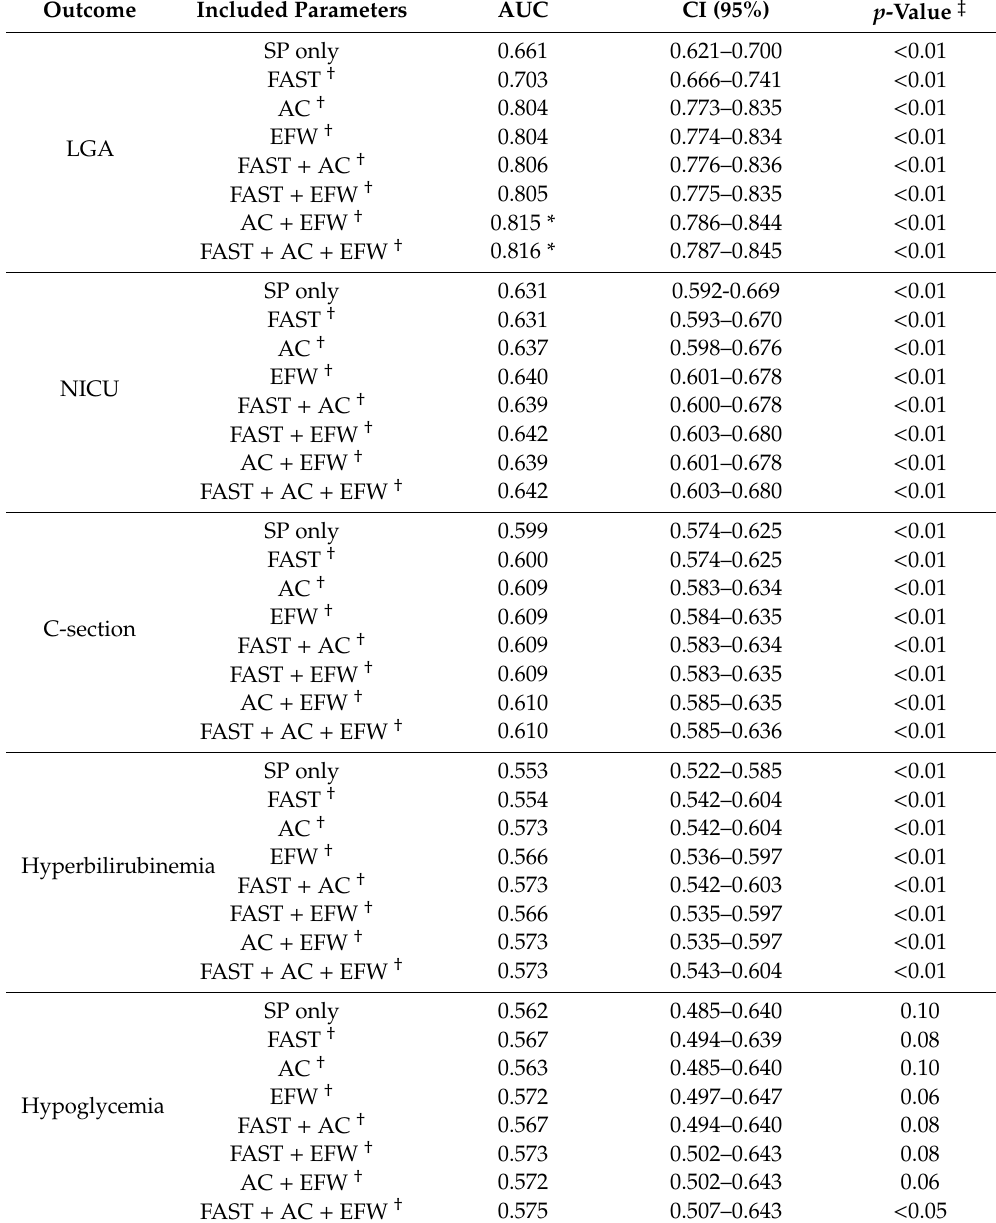
Table 4. Area under the receiver-operating curve for the perinatal outcome parameter: LGA, NICU admission, C-section, hyperbilirubinemia, admission and hyperglycemia using di ff erent combinations of clinical standard parameters and ultrasound-based predicting methods.